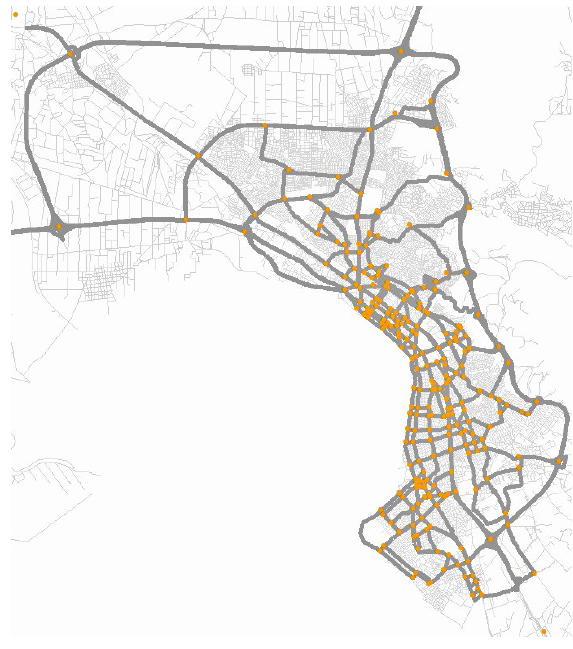
Fig. 3. Intersections and links of the study